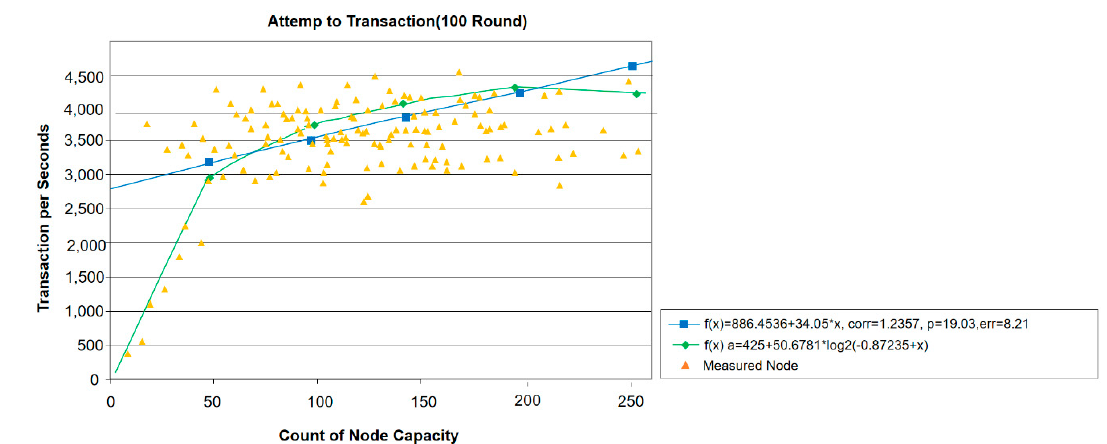
Figure 11. Experimental method (average value of Experiment 100 Round).